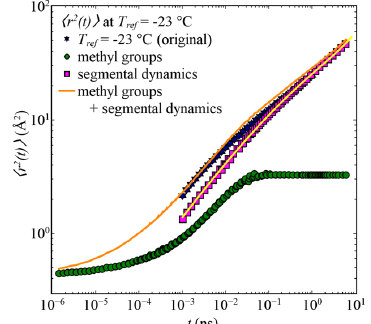
Fig. 14. Mean square displacement, ⟨𝑟 (cid:2870) (cid:4666)𝑡(cid:4667)⟩ , as a function of time, 𝑡 , for Sample 3. Data has been previously published at Bichler et al .[22] As seen by the comparison of the generated mean square displacement, ( Fig. 14 , orange solid line), with the original ⟨𝑟 (cid:2870) (cid:4666)𝑡(cid:4667)⟩ obtained from 𝑆(cid:4666)𝑄 , 𝑡(cid:4667) at that specific reference temperature ( Fig. 14 , blue stars) the used approach can recover the original data well over